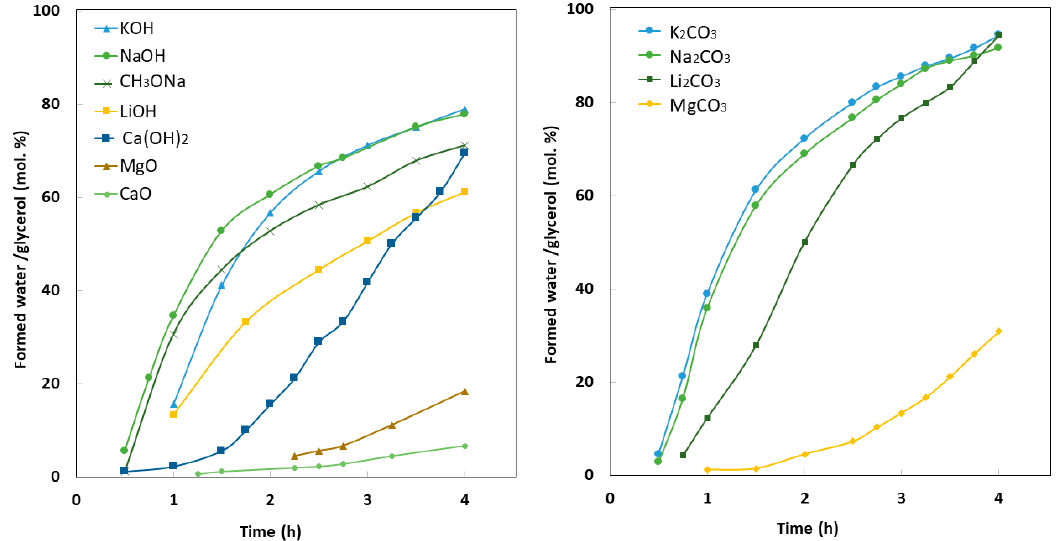
Figure 4. Rate of polymerization reactions based on mole of water formed during the reaction, using carbonates and hydroxides as catalysts (based on data presented in [46]).